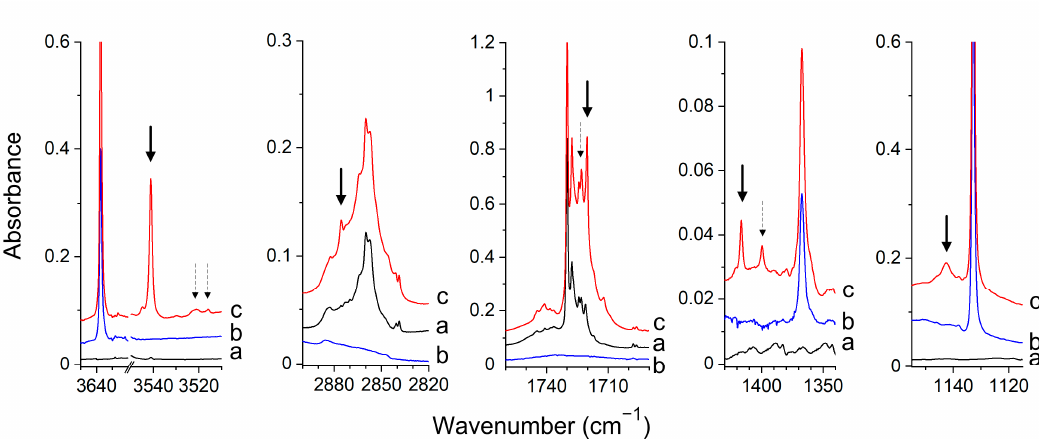
Figure 4. The spectra of the CHOCHO/Ar ( a ), NH 2 OH/Ar ( b ) and CHOCHO/NH 2 OH/Ar ( c ) matrices recorded after matrix deposition at 11 K. The bands of the CHOCHO–NH 2 OH complex are indicated by the arrows.